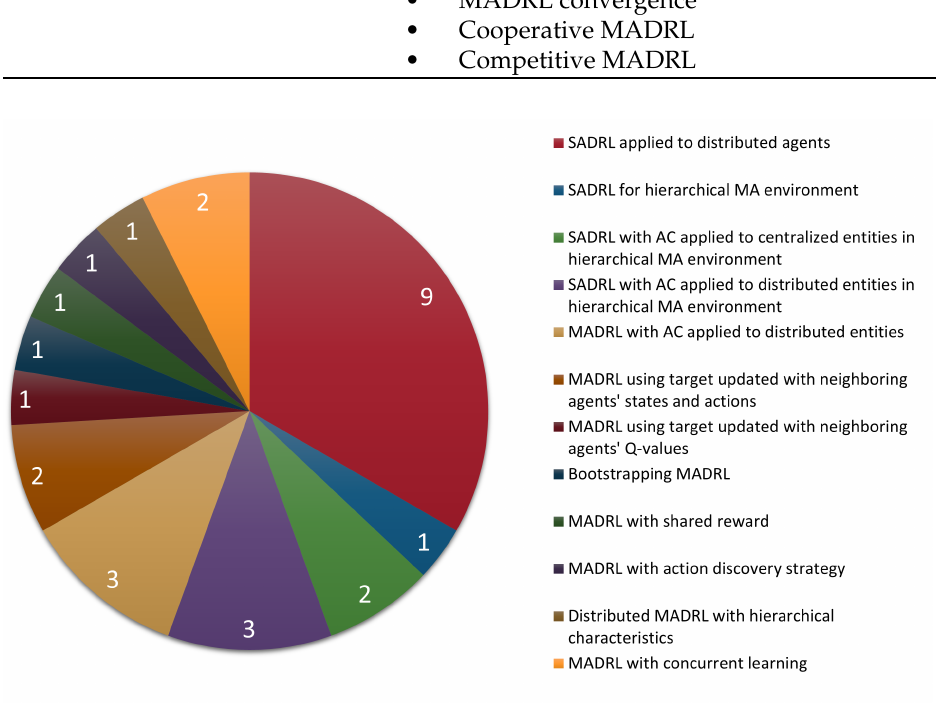
Figure 2. Categories of related papers in the